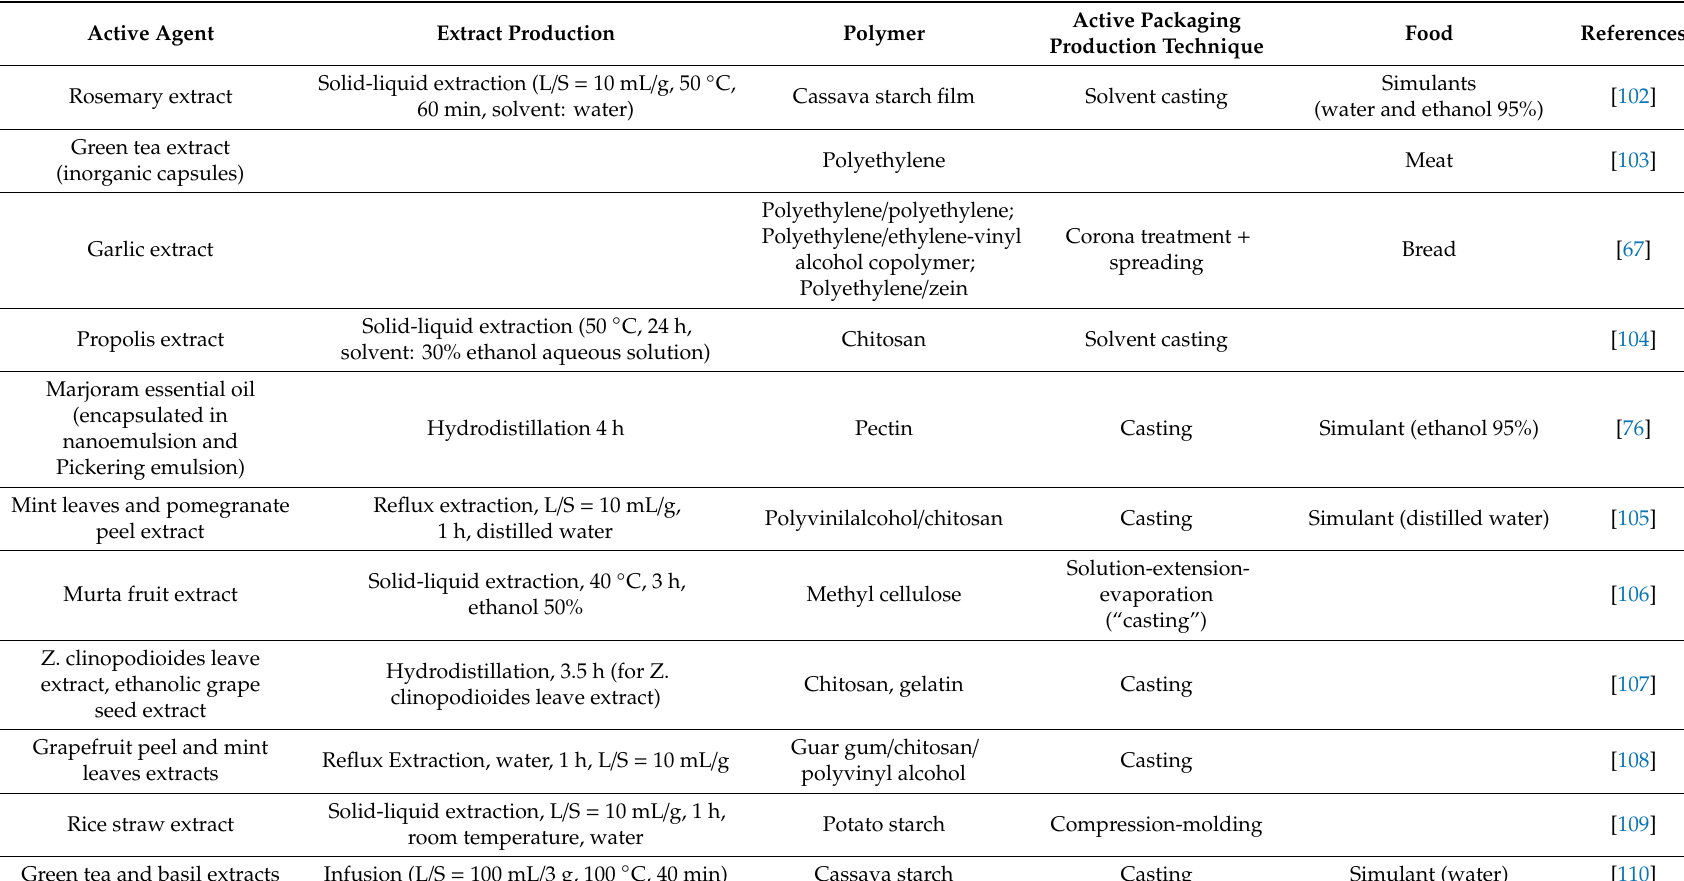
Table 3. Examples of packaging with natural extracts as active